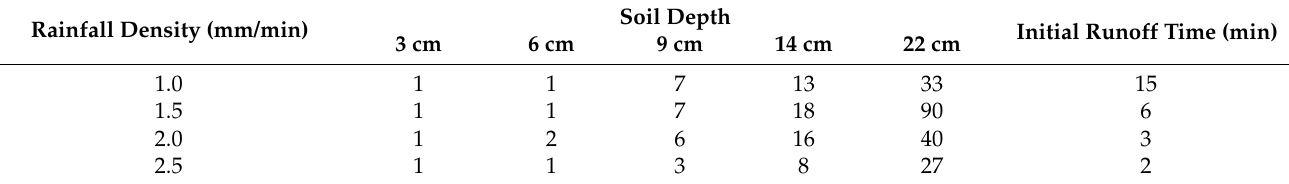
Table 3. The rising time of soil water content curves at different depths on sand-covered slopes.